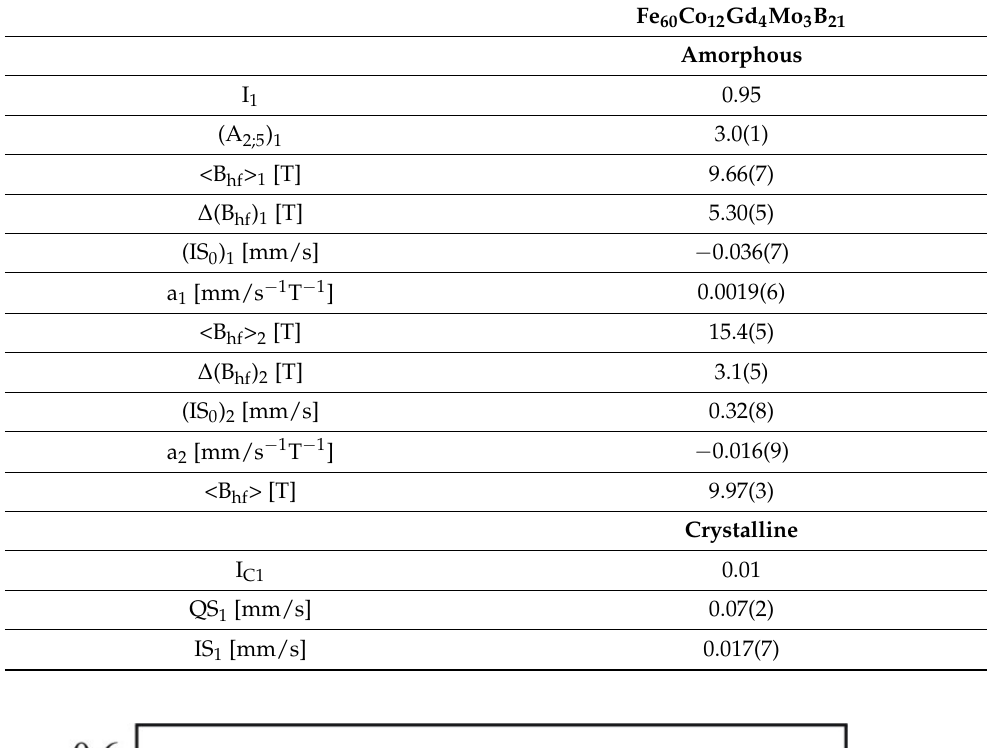
Table 1. The average value of the quadrupole splitting distribution (QS 1 ), isomer shift of the single line (IS 1 ) and its relative intensity (I C1 ), the relative intensity of the second and fifths line in sextet (A 2;5 ), average hyperfine field <B hf >, average hyperfine field of components <B hf > i their standard deviations ∆ <B hf > i , parameters of linear dependence between (B hf ) i and IS i (IS 0i and a i ) and their relative intensities (I i ) (i = 1, 2, C1) for each components, respectively, of Fe 60 Co 12 Gd 4 Mo 3 B 21 . alloys in the as-quenched state. Uncertainties for the last significant figure are given in brackets.